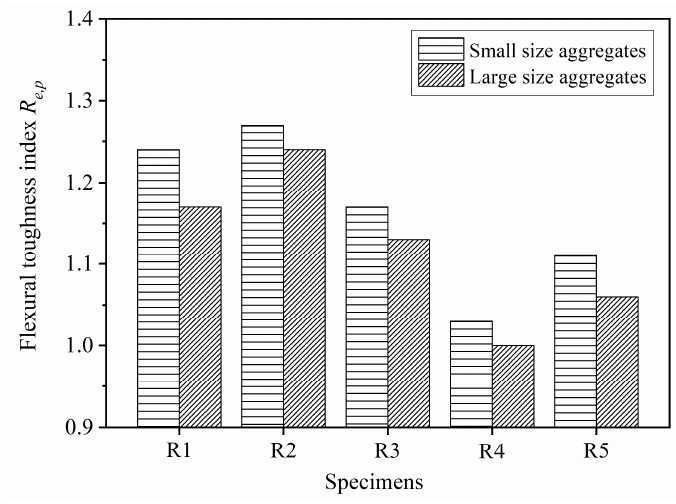
Figure 15. Toughness index R e , p of the geogrid-reinforced beam.